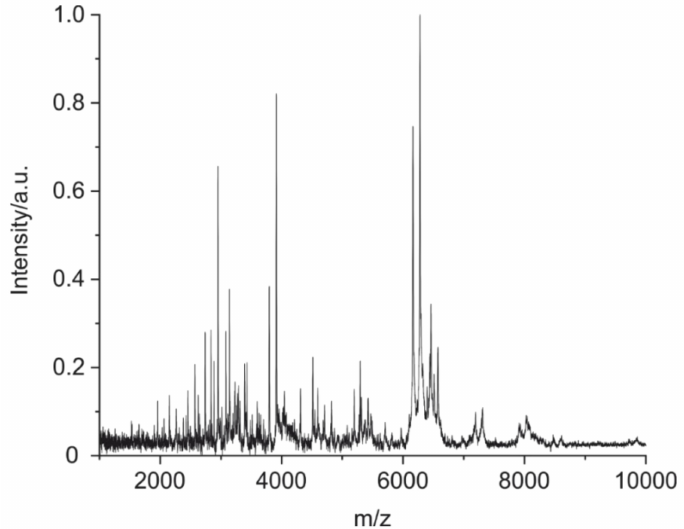
Figure 8. MALDI-TOF MS spectra of a cleaved mouse IgG1 (BAM-mab 02 (E1)) under optimized conditions: 1) Optional enrichment of IgG by magnetic particles with immobilized protein G; 2) cleavage of 1 µ g of IgG with 2% of formic acid plus TCEP at 90 ◦ C for 5 h; 3) cleanup on pipet tip SPE; 4) elution with alpha-cyano-4-hydroxycinnamic acid in acetonitrile / water / trifluoroacetic acid (TFA) and application on MALDI target (a calibration polymer was applied on a separate spot on the target); and 5) the MALDI-TOF MS measurement was performed in the linear, positive